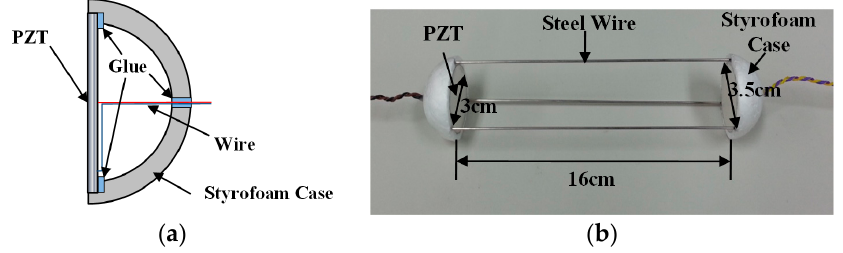
Figure 1. Embedded piezoelectric sensor. ( a ) Schematic of the embedded piezoelectric sensor; ( b ) The proposed embedded piezoelectric sensor module.